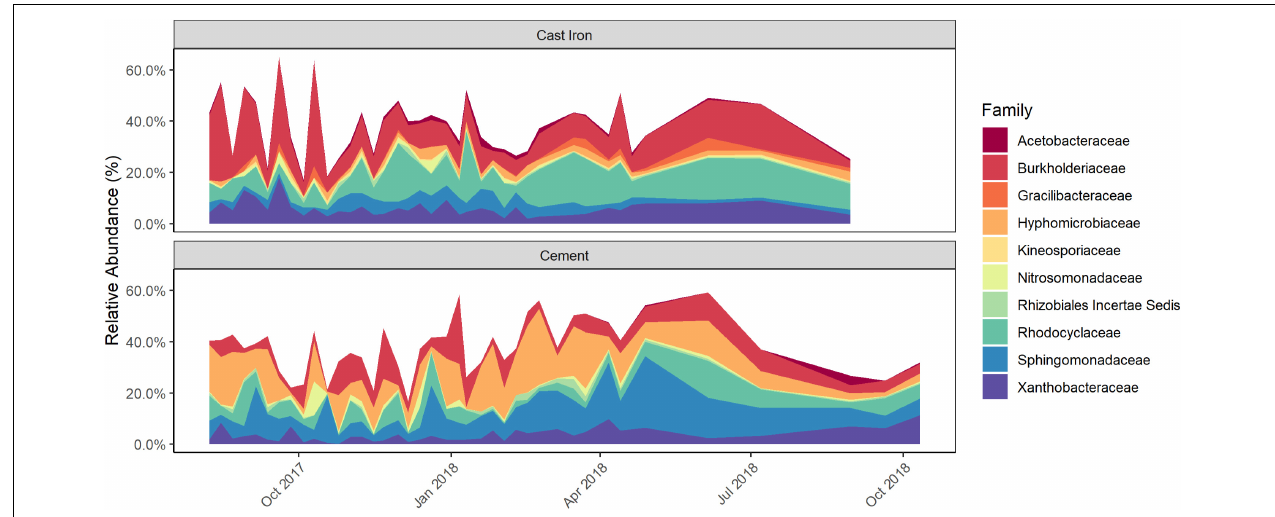
FIGURE 3 | Relative abundance of differentially abundant taxa in cast iron and cement annular reactor (AR) biofilm samples over the 16-month study period as identified by Longitudinal Analysis of Composition of Microbiomes (ANCOM) analysis. At each time point, one coupon was collected from the set of cast iron ARs and the set of cement ARs. One coupon from each set was collected weekly for the first 34 weeks and the monthly for four additional months (cast iron ARs) and six additional months (cement ARs). A total of 38 coupons from the cast iron ARs and a total of 40 coupons from the cement ARs were